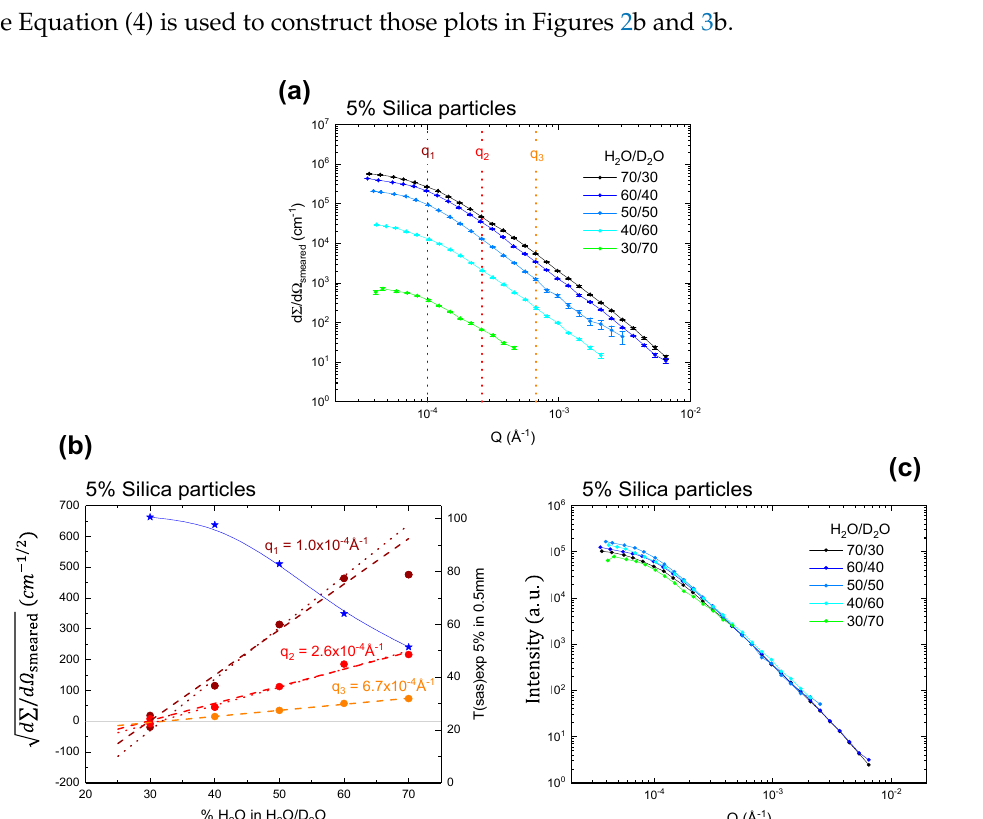
Figure 2. Contrast variation with 5 vol % SiO 2 at pH 10. ( a ) Scattering curves of samples with different H 2 O/D 2 O ratios; ( b ) left axis: the square root of the scattering intensity as a function of vol % H 2 O in H 2 O/D 2 O ratio and q value (brown, red and orange symbols for the three distinct q -values). The fitted line corresponds to the data with a positive sign (dashed line) and negative sign (dotted line) sign for the first point, respectively. Right axis: T SAS,exp in 0.5 mm path length (blue stars) as a function of vol % H 2 O in H 2 O/D 2 O ratio; ( c ) a plot of the scattering curves from ( a ) normalized to the same value at high q .